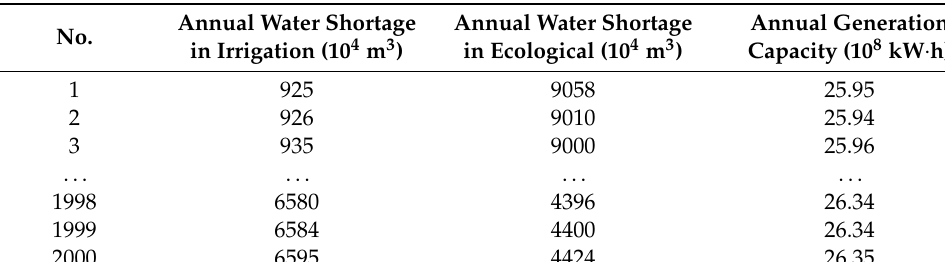
Table 1. Multi-objective Pareto optimal set.